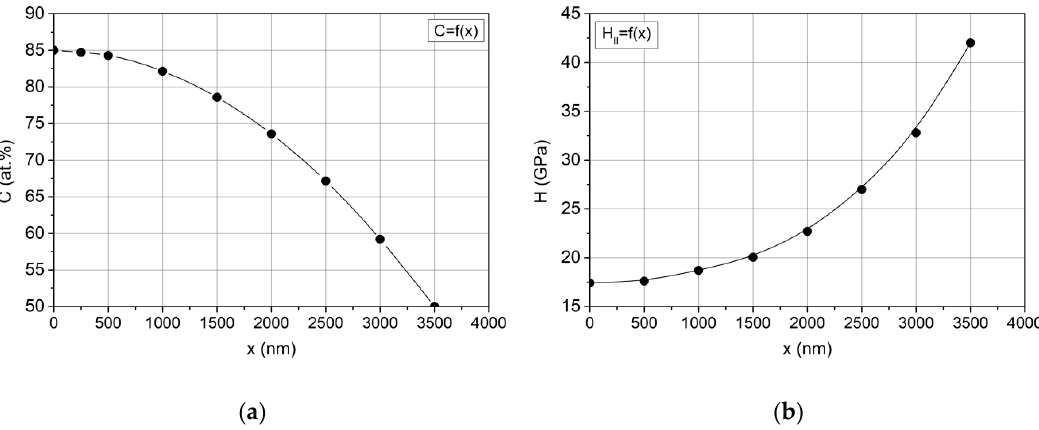
Figure 5. ( a ) Parabolic change in carbon content in the concentration range of 50–85 at.% determined using Formula (3) and ( b ) change in coating hardness determined from accepted carbon content profile and changes in hardness calculated according to mixtures rule (Formula (2)).